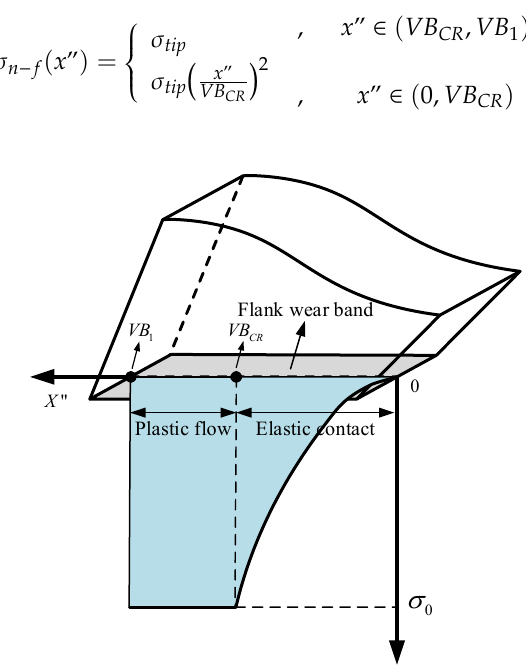
Figure 8. Distribution of normal stress over the wear band on the Figure8. Distribution of normal stress over the wear band on the flank.